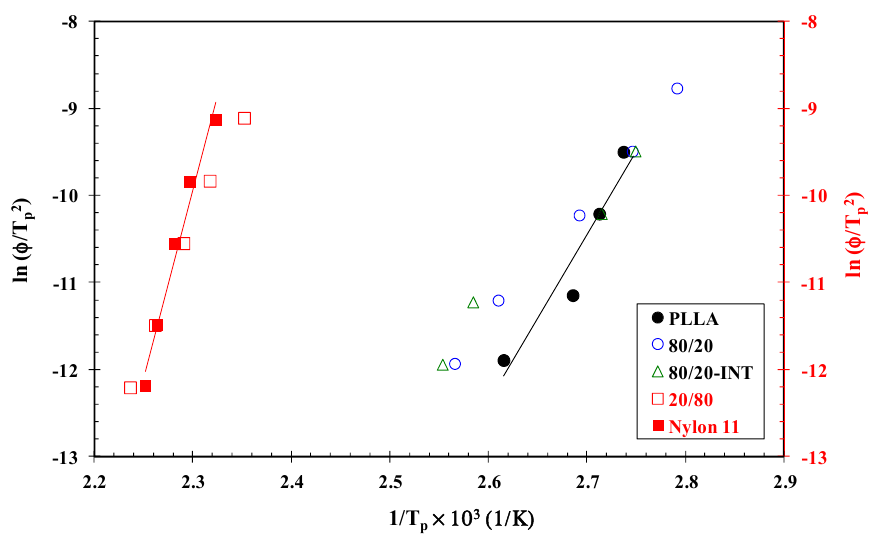
Figure 8. Kissinger plot for PLLA, nylon 11, PLLA/nylon 11 blends and PLLA/nylon 11-INT nanocomposites obtained from non-isothermal crystallization traces after fitting the data at the cooling rates of 1, 2, 5, 10 and 20 °C/min.